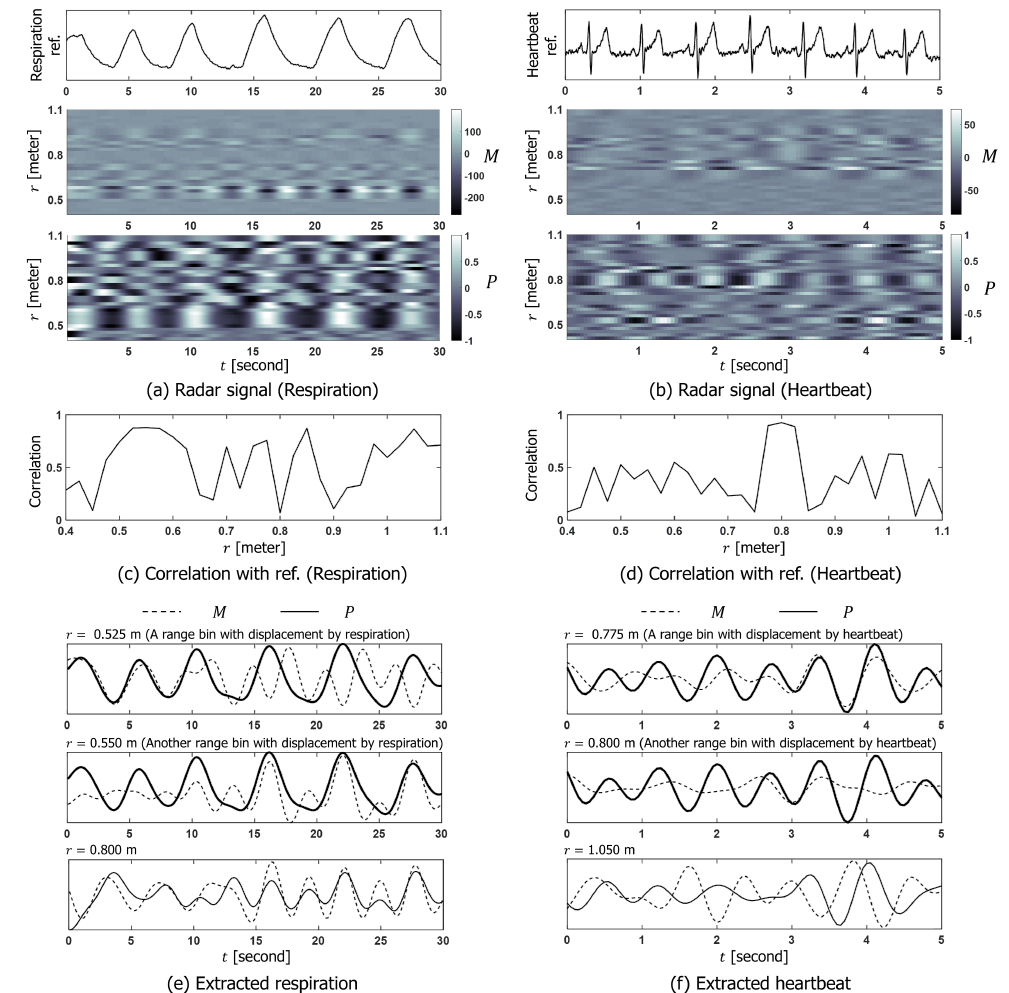
Figure 2. Measured vital-sign signals. ( a , b ) M ( t , r ) and P ( t , r ) of respiration and heartbeat, ( c , d ) temporal correlation coefficient between P ( t , r ) and referenced vital-sign, and ( e , f ) respiration and heartbeat in several